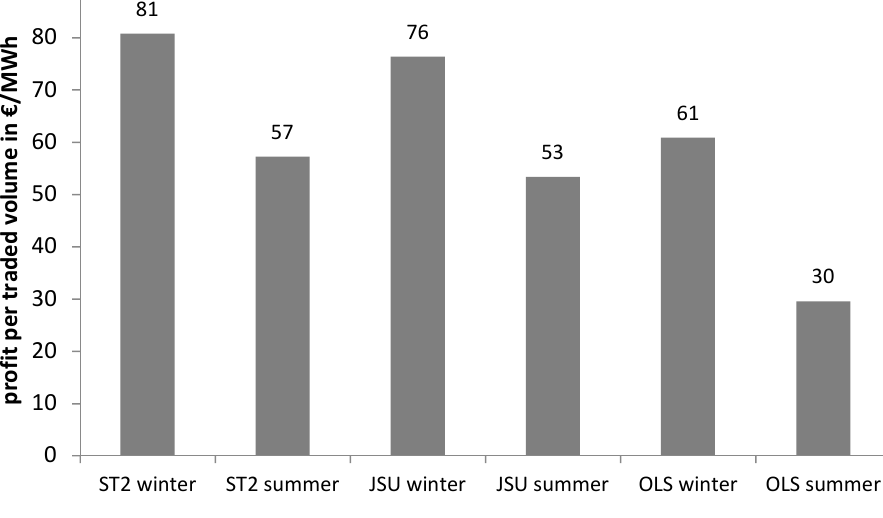
Figure 3. Profit per traded MWh.